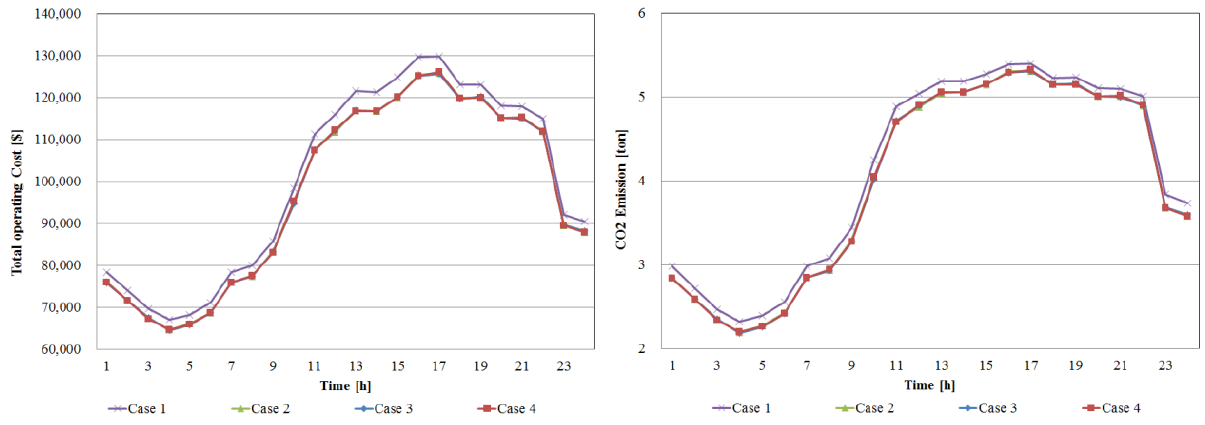
Figure 11. Total operating cost and CO